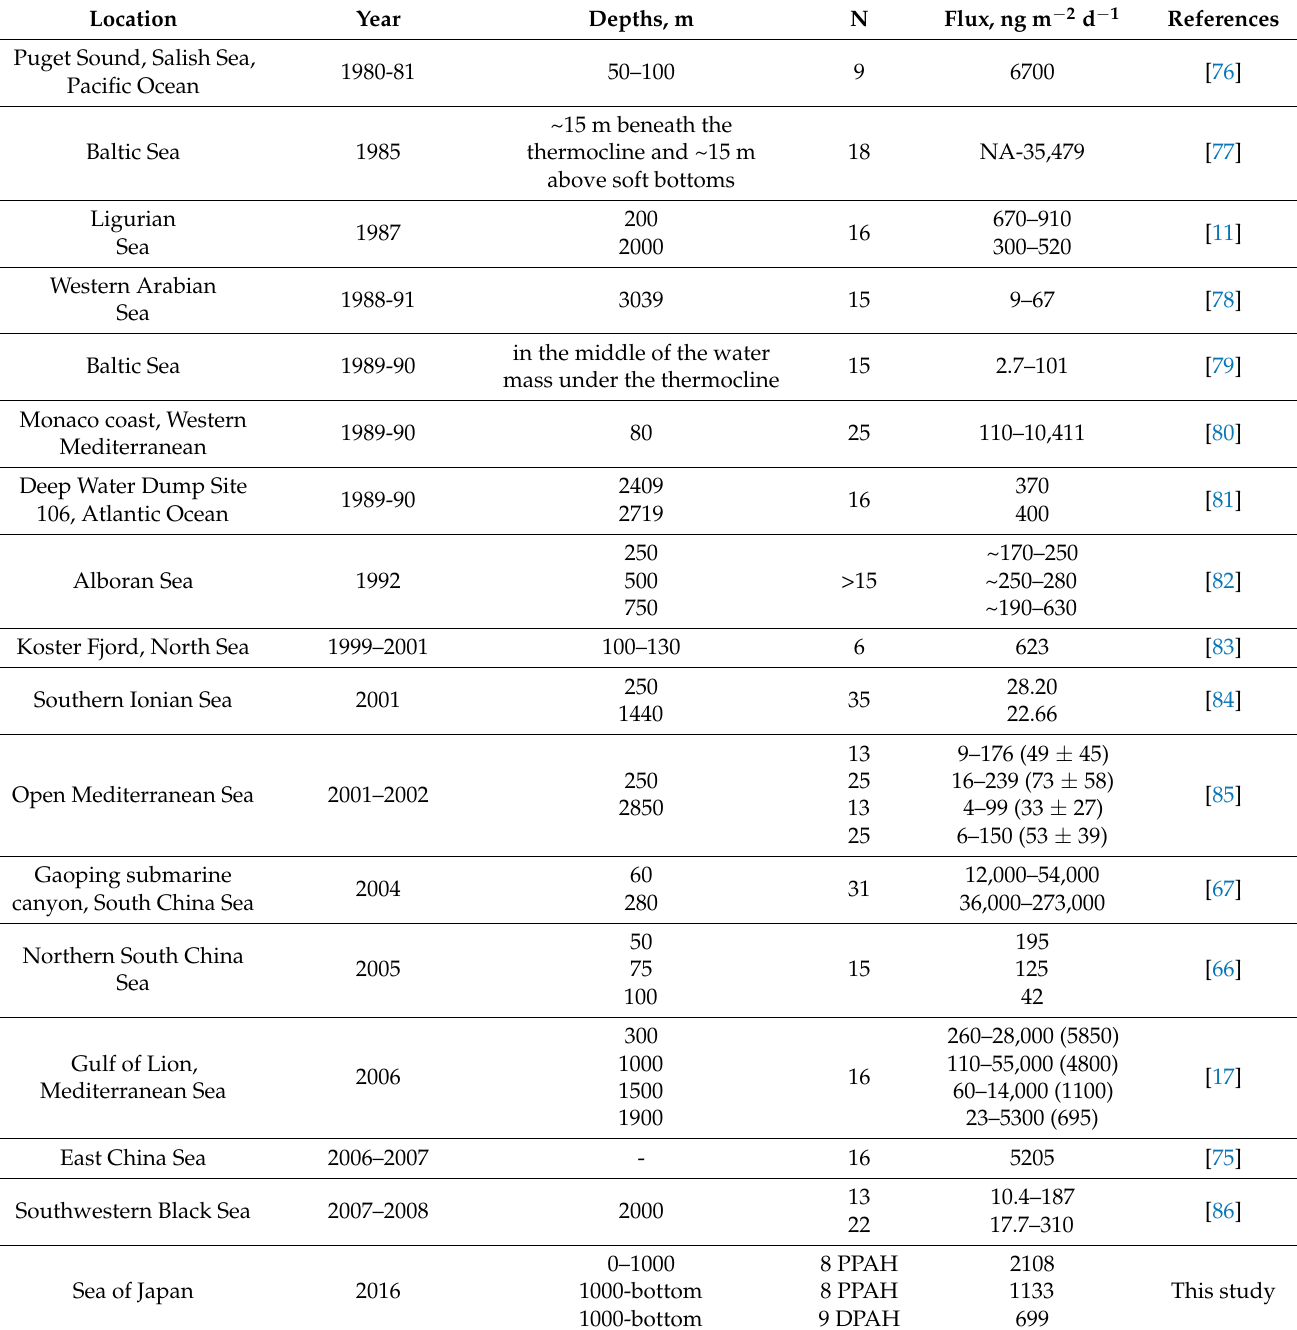
Table 3. The PAH fluxes in sinking particles in the different sea